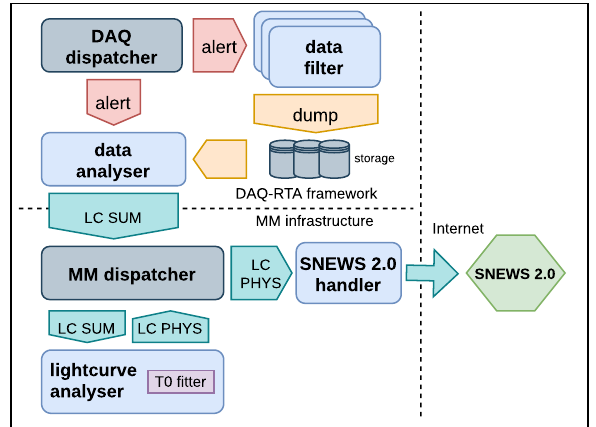
Fig. 3 Overview scheme of the quasi-online analysis